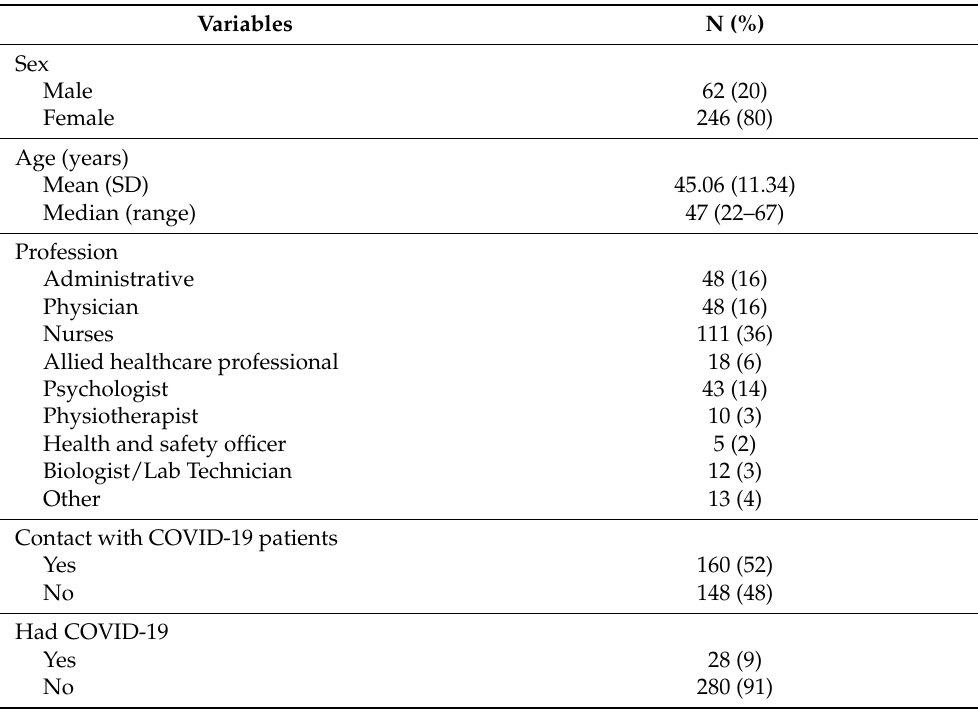
Table 2. Sociodemographic characteristics and COVID-19 experience of the responding